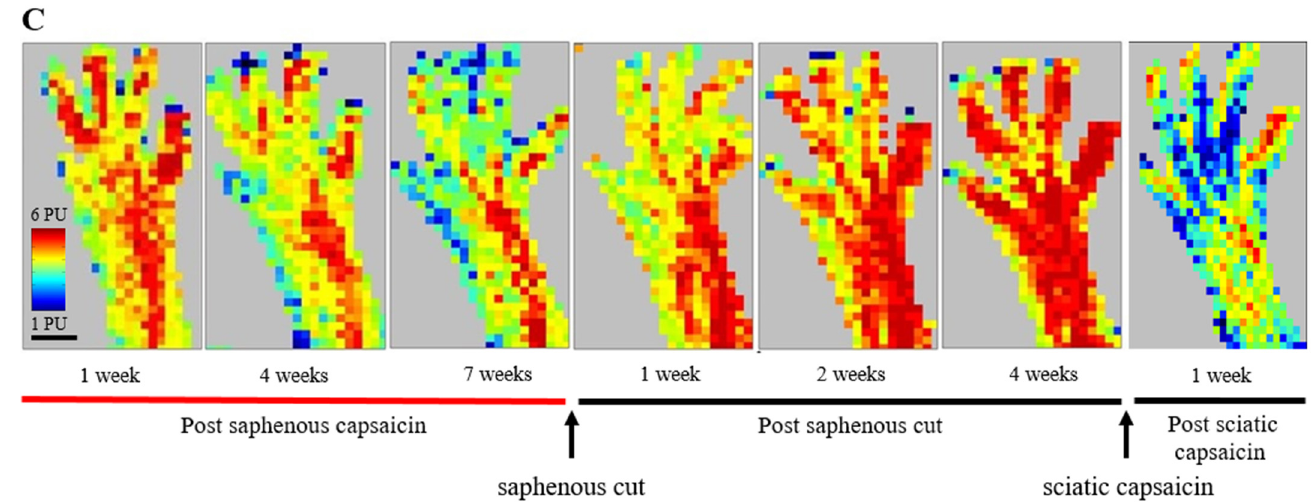
Figure 3. ( A ) Calculation of denervated skin areas following perineural capsaicin treatment of the saphenous nerve and subsequent transection of that nerve 7 weeks later ( n = 9). *: significantly different from the skin area determined 1 week after perineural capsaicin treatment. ( B ) Calculation of reinnervated skin areas following transection of the saphenous nerve treated perineurally with capsaicin 7 weeks previously ( n = 7). *: significantly different from the denervated area determined 1 week after perineural capsaicin treatment. ( C ) A series of laser Doppler scanning perfusion images of the rat hind paw following perineural capsaicin treatment of the saphenous nerve and subsequent transection of the saphenous nerve and perineural capsaicin treatment of the sciatic nerve 7 and 11 weeks later, respectively. Scale bar represents 5 mm.